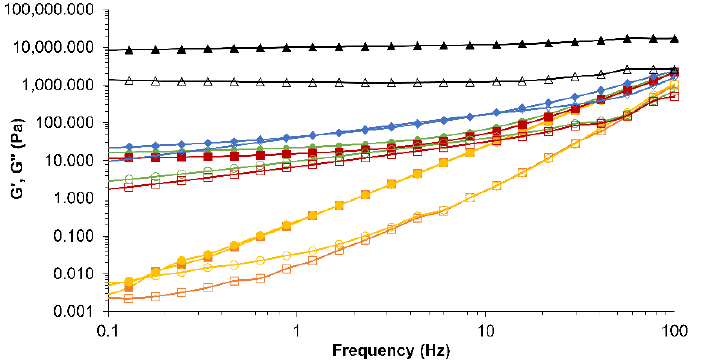
Figure 4. Dynamic moduli as a function of frequency of emulsions and butter . Conventional emulsion (CE-0 ; CE-2 ; CE-4 ). Nanoemulsion (NE-0 ; NE-2 ). Filled symbols correspond to elastic modulus (G’) and open symbols to viscous modulus (G”).